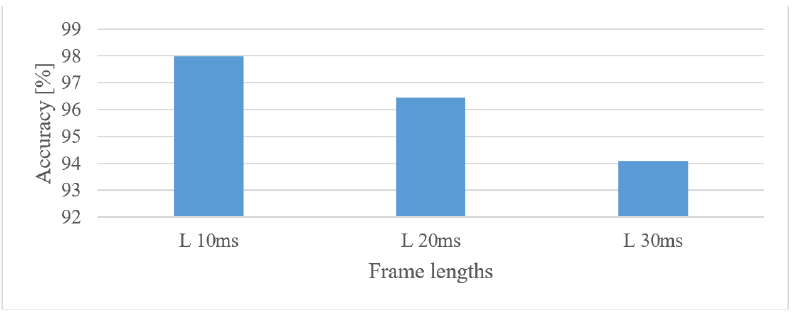
Figure 5. Averaged accuracies for 10, 20, 30 ms frame lengths (L) and 50% shifts for 1 s-long 0–10 kHz spectrograms. 0–10 kHz spectrograms.